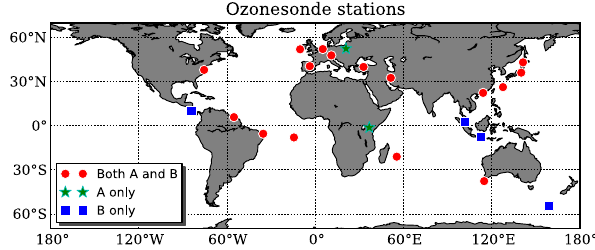
Fig. 11. Ozonesonde stations where coincidences were found in this study. Red dots are observation points where coincidences were found between ozonesondes and both Band-A and Band-B. Green stars are those where comparisons were between ozoneson- des and Band-A. Blue squares are those for the comparison between ozonesondes and